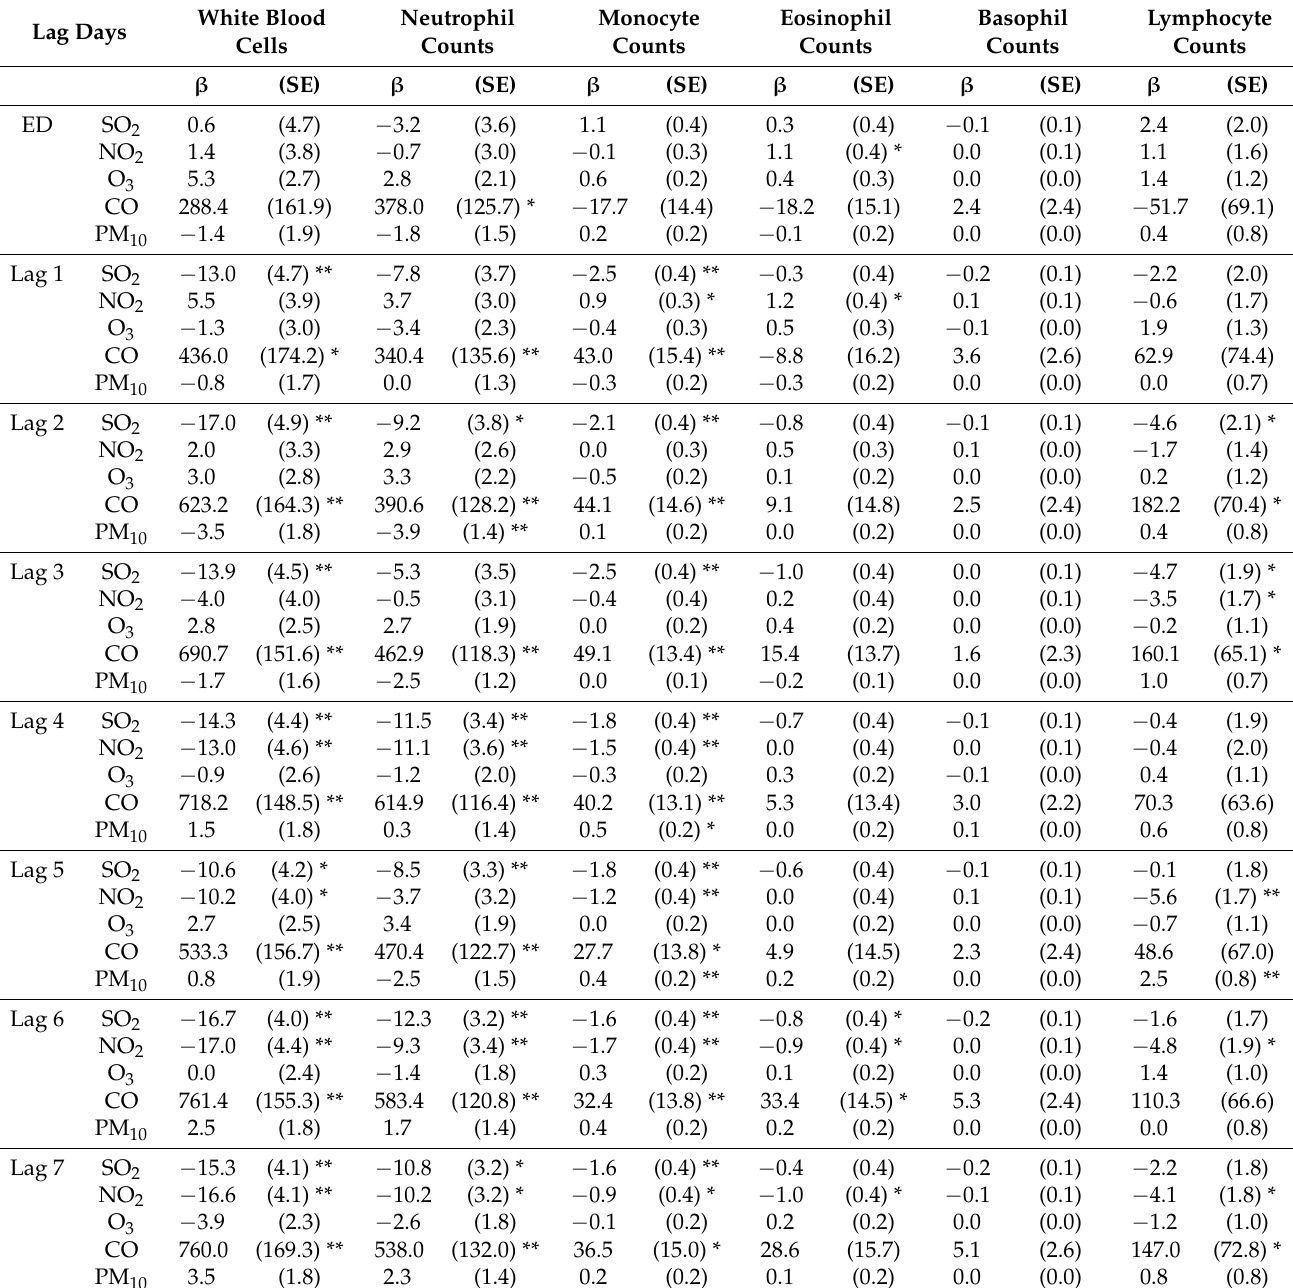
Table 4. Multiple-pollutant model: the associations between common air pollutants and white blood cells after adjusting gender, age, BMI, smoking, drinking, and betel quid